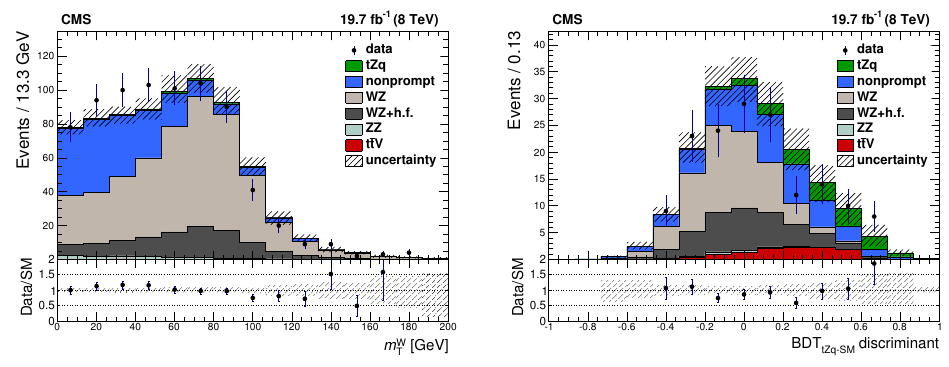
Figure 4 . Data-to-prediction comparisons after performing the (cid:12)t for m W region (left) and for the BDT tZq-SM responses in the signal region (right). The four lepton channels are combined. The lower panels show the ratio between observed and predicted yields, including the total uncertainty on the